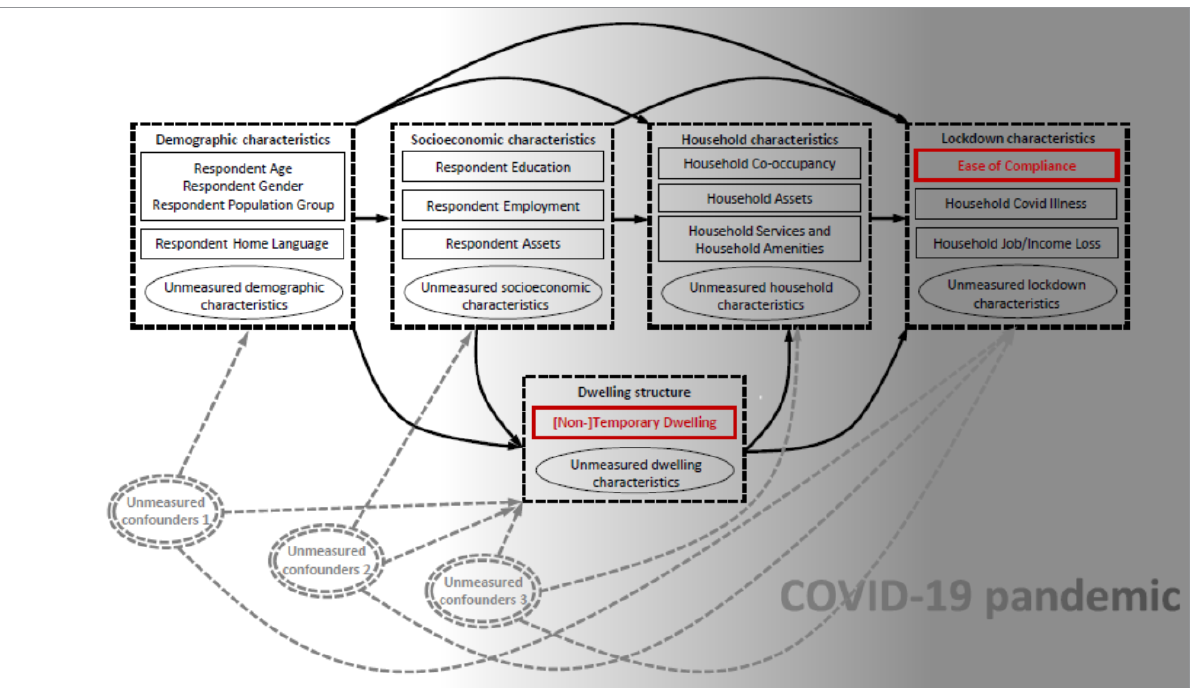
A theoretical causal path diagram, drawn in the form of a directed acyclic graph in which each of the measured (rectangles) and unmeasured (ellipses) sets of variables of relevance to the present study have been arranged in their hypothesised temporal sequence (from left to right), with each preceding variable assumed to act as a probabilistic cause of all subsequent variables. The two specified outcomes (‘[Non-]Temporary Dwelling’ and ‘Ease of Compliance’) have been indicated in red. Three examples of the many different unmeasured sets of covariates (indicated by ellipses with double outlines) likely to contribute confounder bias to estimates of the focal relationships examined in the present study, have been included to emphasise their potential